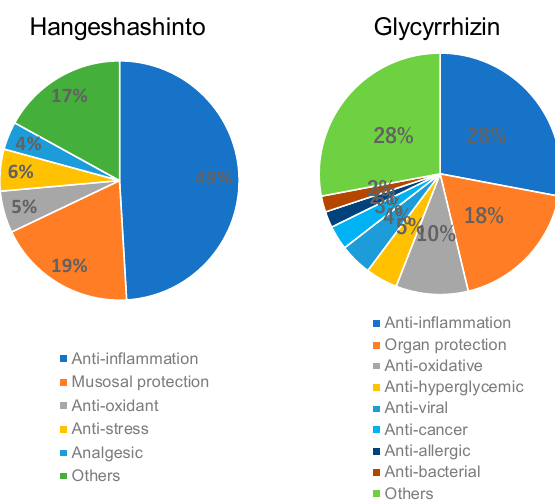
Figure 6. Prominent anti-inflammatory activity of Hangeshashinto.